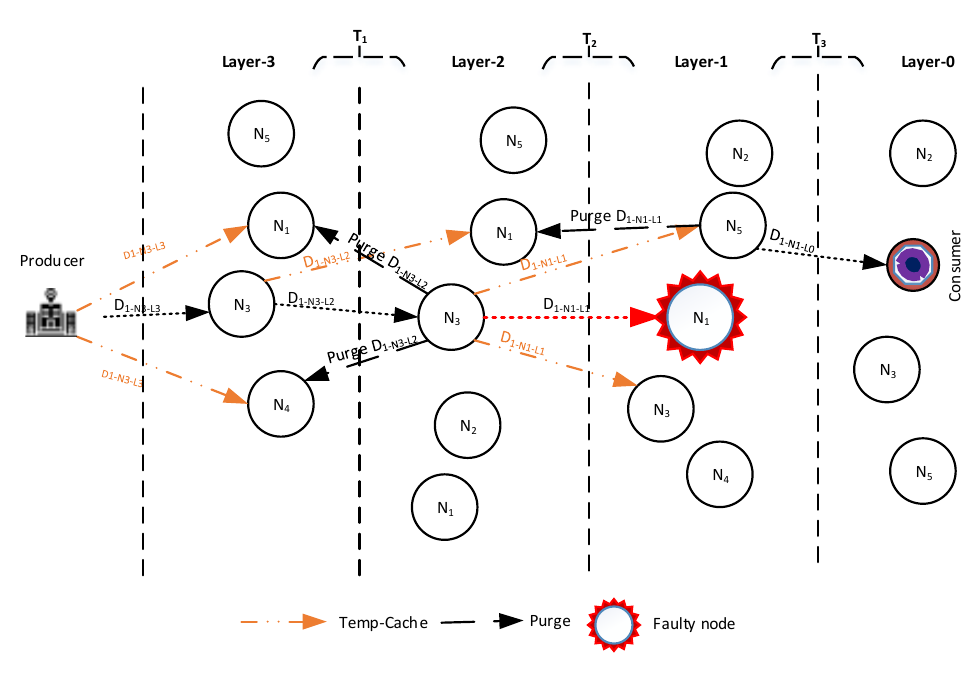
Figure 6. Data packet